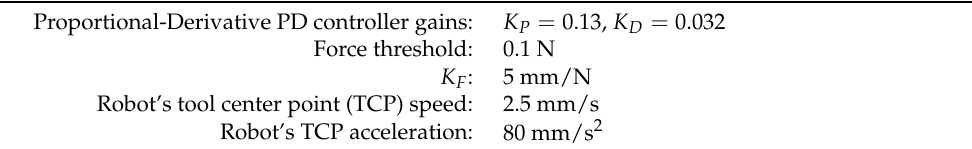
Table 1. Parameters used in the test scenario. Proportional-Derivative PD controller